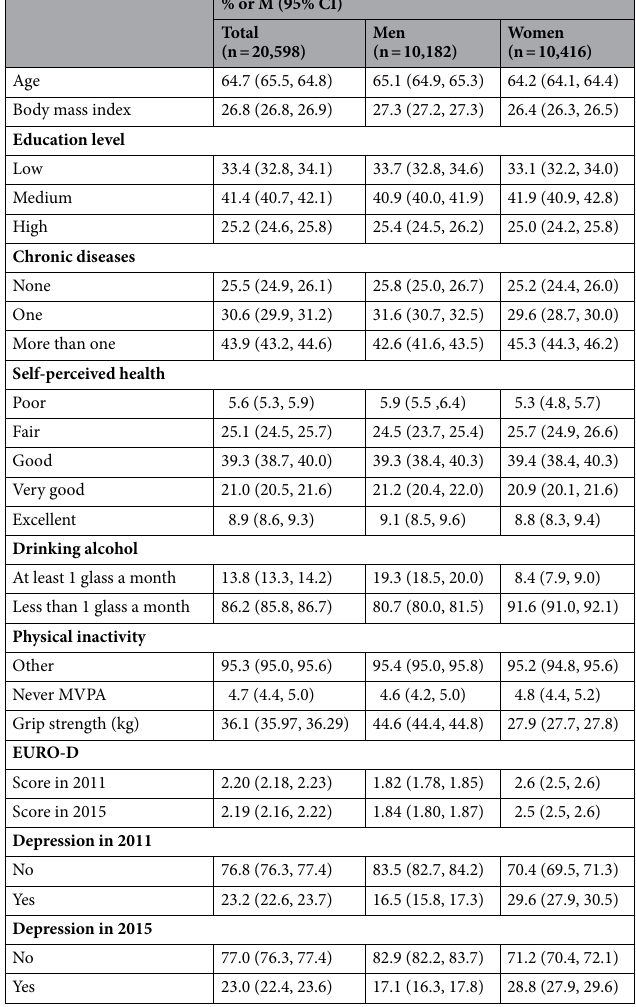
Table 1. Participants characteristics, total sample and by sex. M mean, CI confidence interval, MVPA moderate or vigorous physical activity.